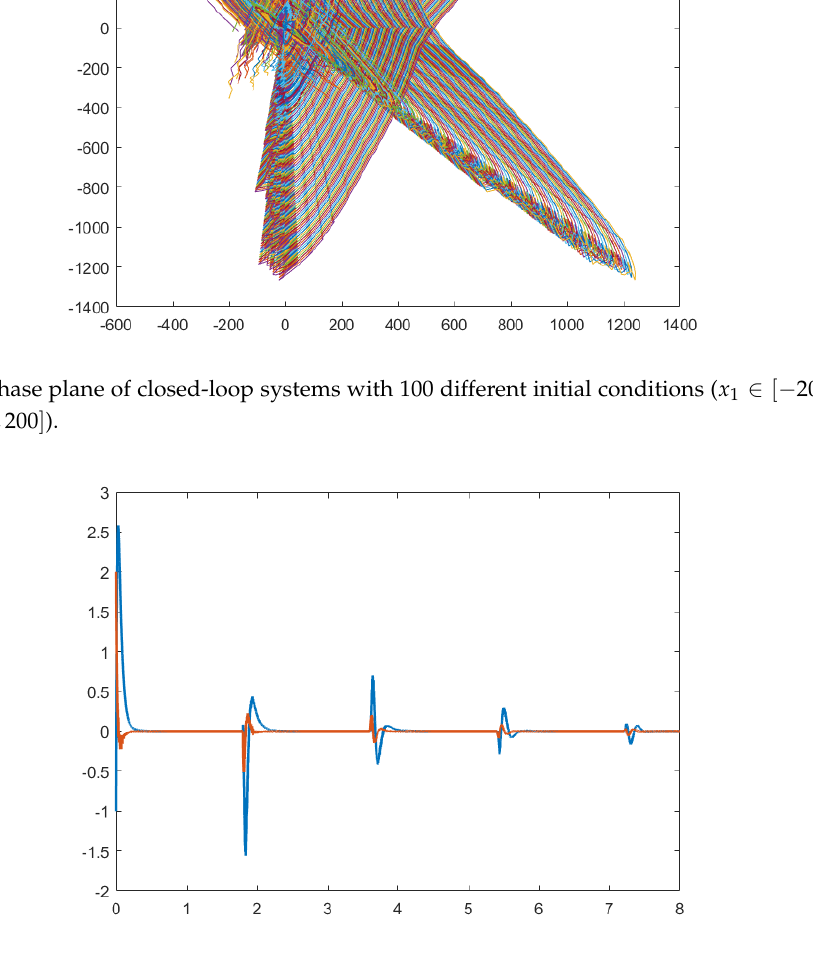
Figure 10. The state trajectories of closed-loop systems without the time-delay term of the